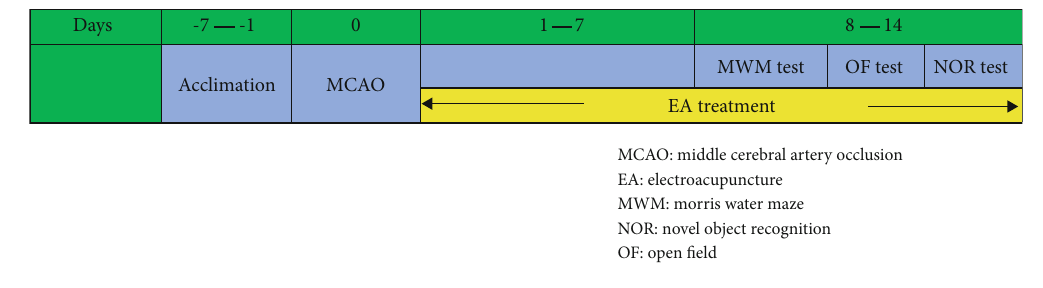
Figure 1: The experimental